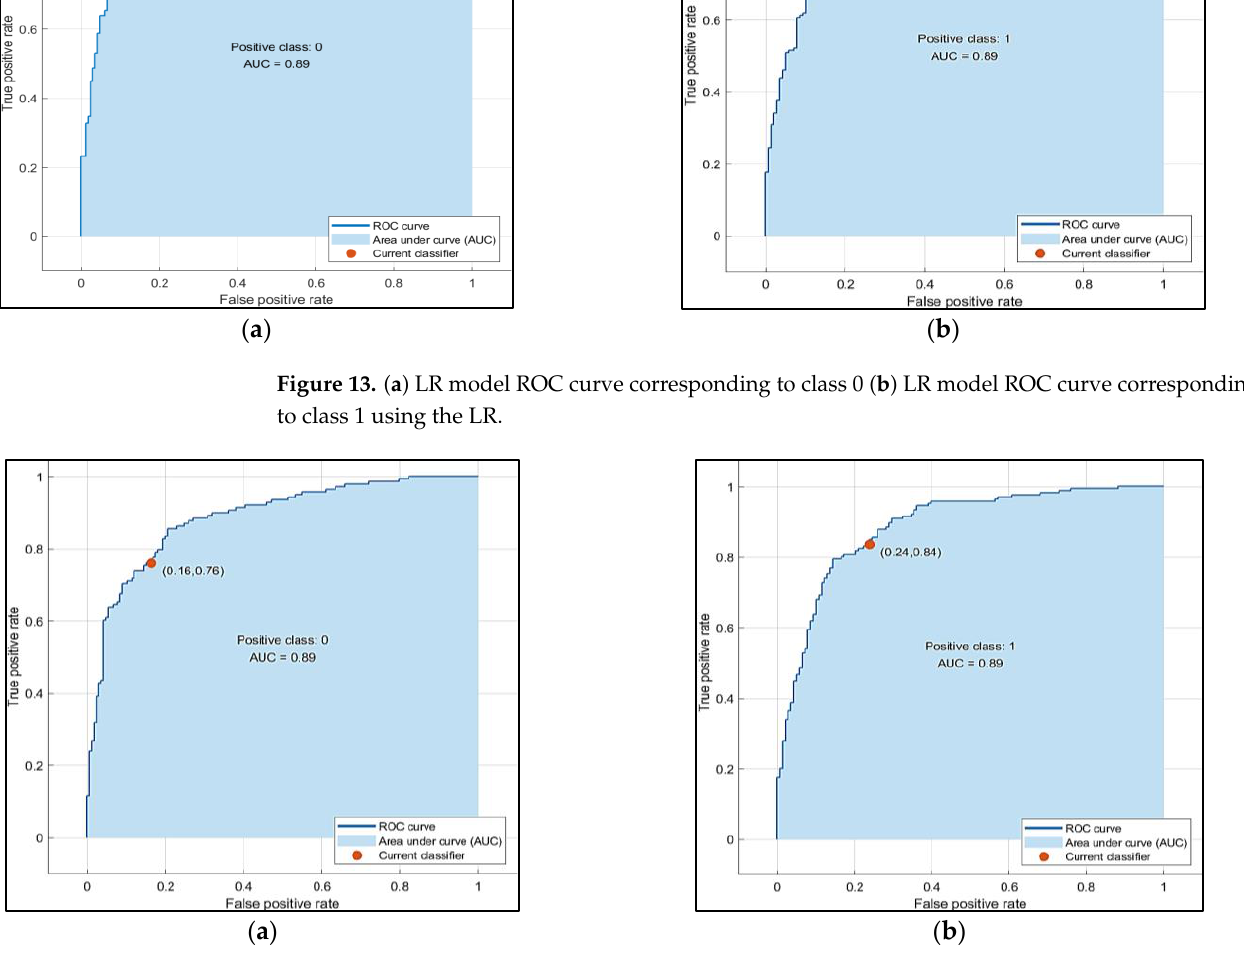
Figure 14. ( a ) Gaussian naive Bayes model ROC curve corresponds to class 0. ( b ) Gaussian naive Bayes model ROC curve corresponds to class 1.